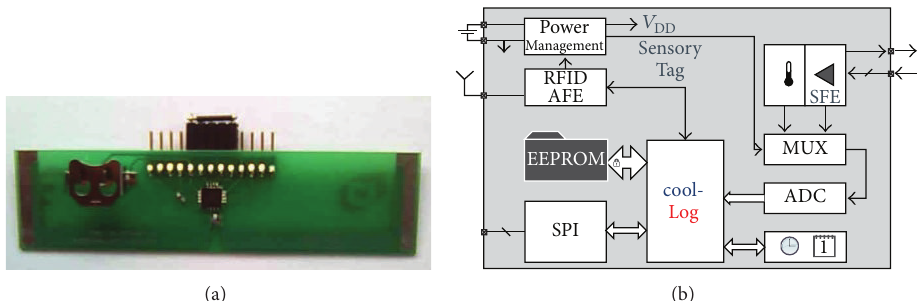
Figure 2: (a) The ams data logger-SL900A; (b) EPC Gen2 C3 single-chip data logger scheme [13].